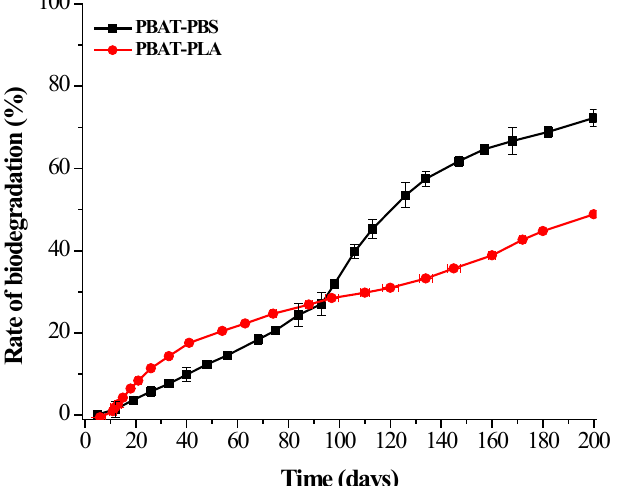
Figure 7. Biodegradation of the PBAT–PLA and PBAT–PBS blends under home composting condi-